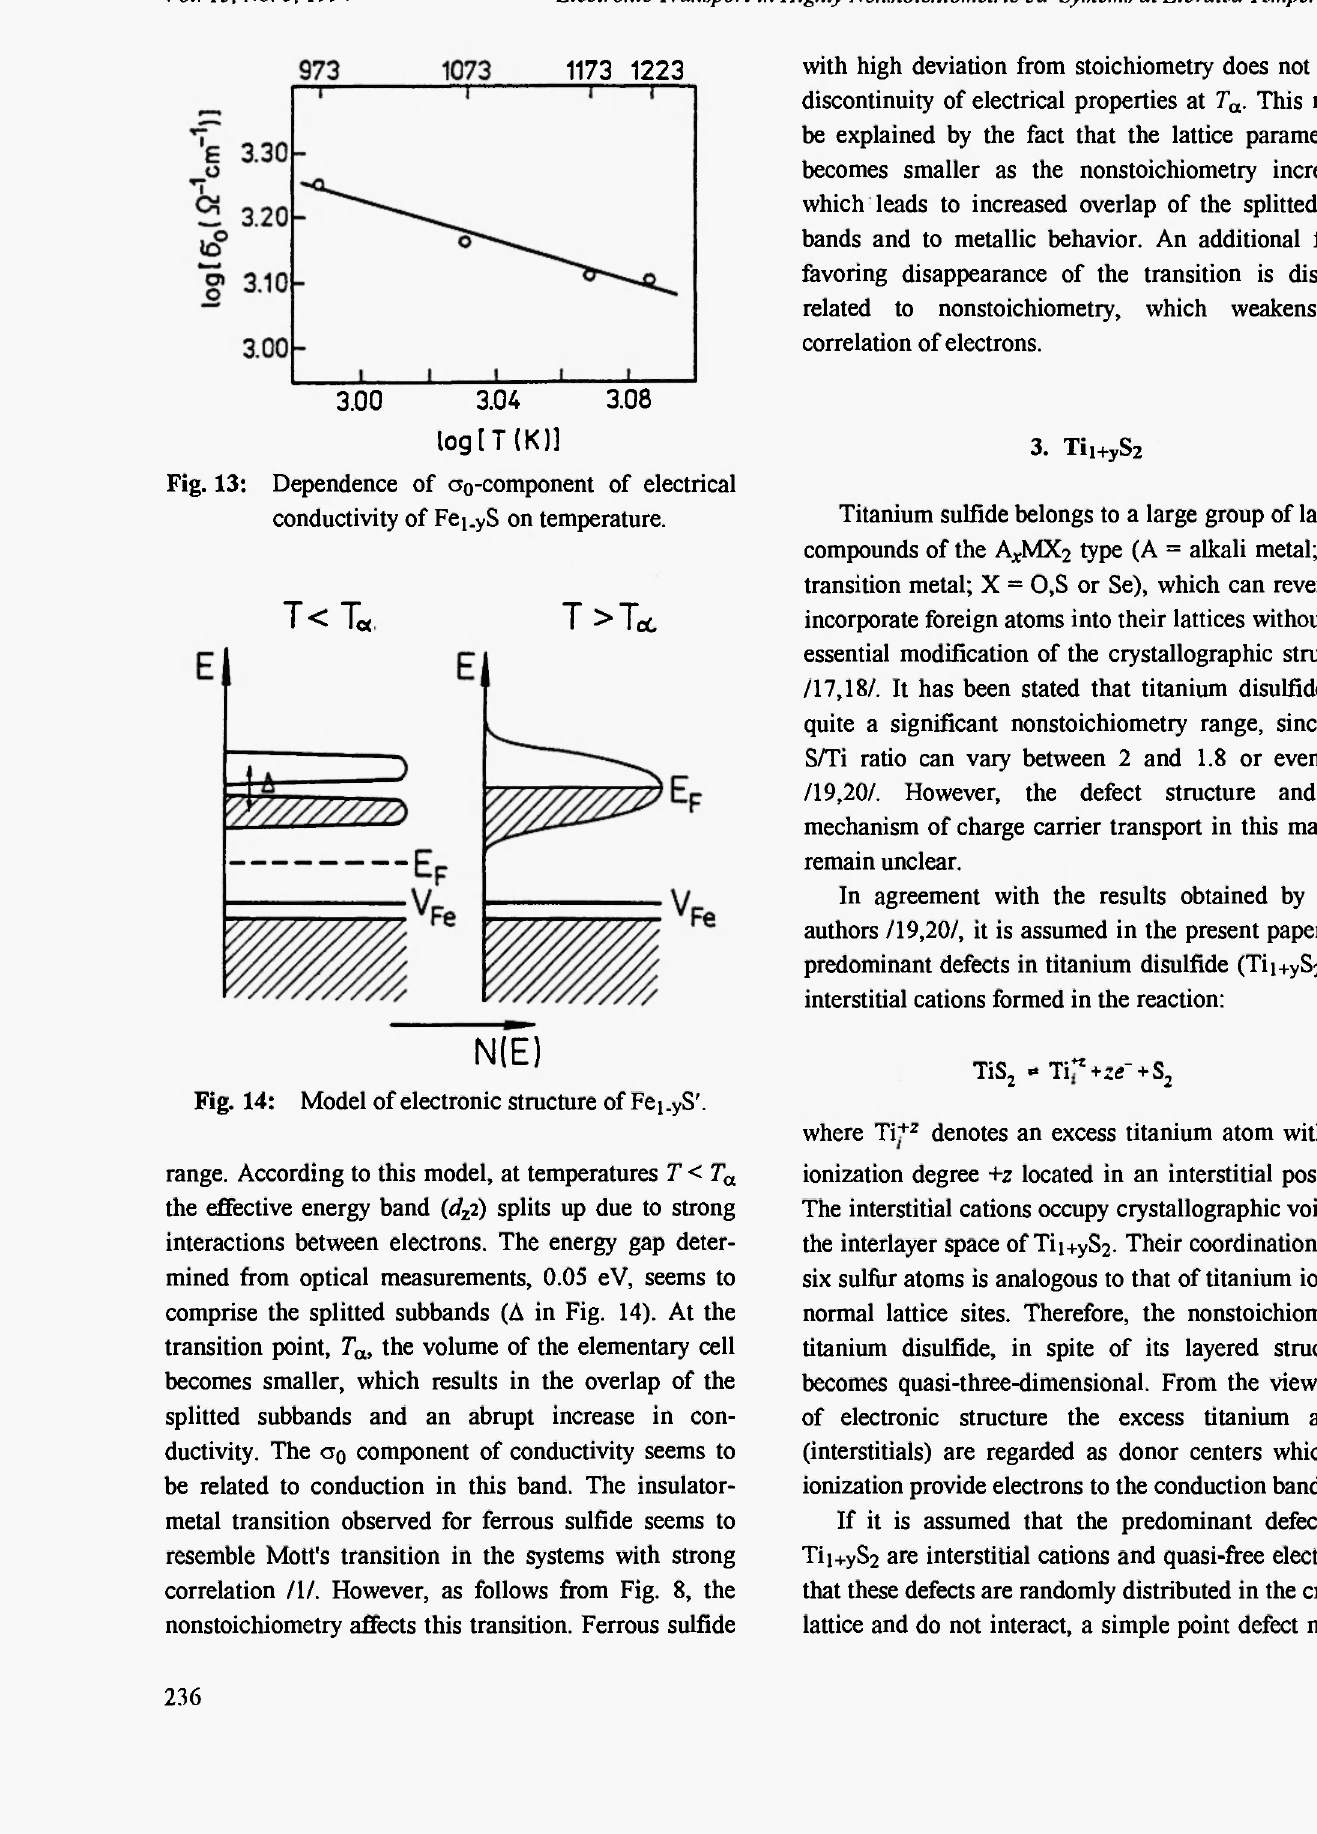
Fig. 14: Model of electronic structure of